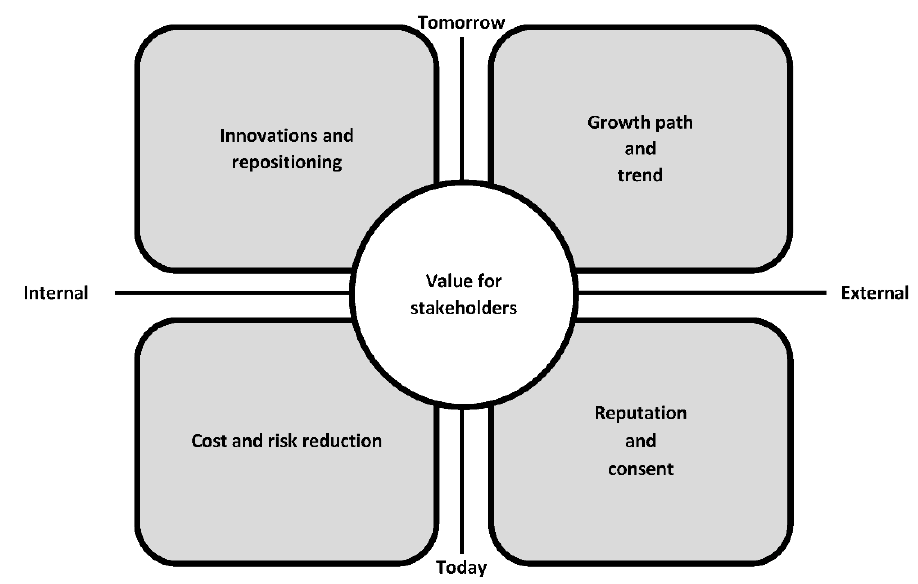
Figure 4. Components of the shareholder value model. Source: Stuart L. Hart and Mark B. Milstein, Creating sustainable value, Academy of Management Executive , 2003, Vol. 17, No. 2, pp. 57.